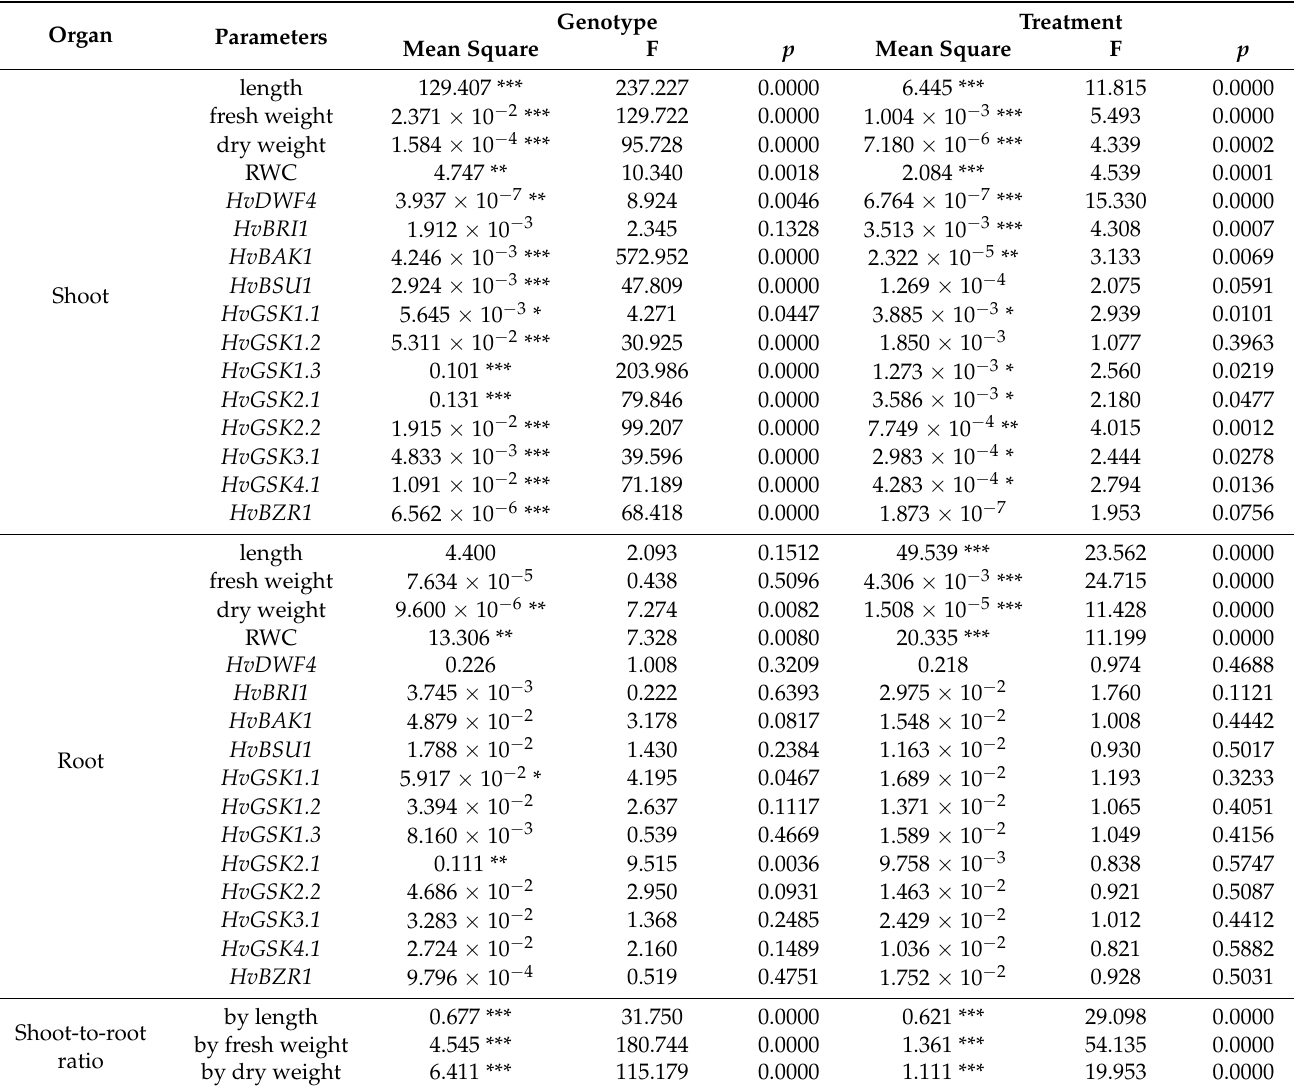
Table 1. Results of two-way ANOVA for the genotype (Golden Promise and Haruna Nijo) or treatment (0.001 and 1 µ M 24-EBL, 10 and 50 µ M bikinin, 10 and 50 µ M Brz) calculated for different growth parameters (shoot and root length, their fresh and dry weight, and related shoot-to-root ratio) and genes ( HvDWF4 , HvBRI1 , HvBAK1 , HvBSU1 , HvGSK3, HvGSK1.1 , HvGSK1.2 , HvGSK1.3 , HvGSK2.1 , HvGSK2.2 , HvGSK3.1 , HvGSK4.1 , HvBZR1) . The asterisks indicate significant